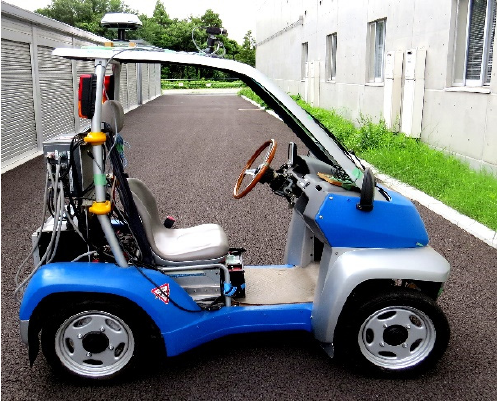
Figure A2. Electric vehicle COMS (Hori-Fujimoto Lab, Kashiwa Campus, The University of Tokyo).